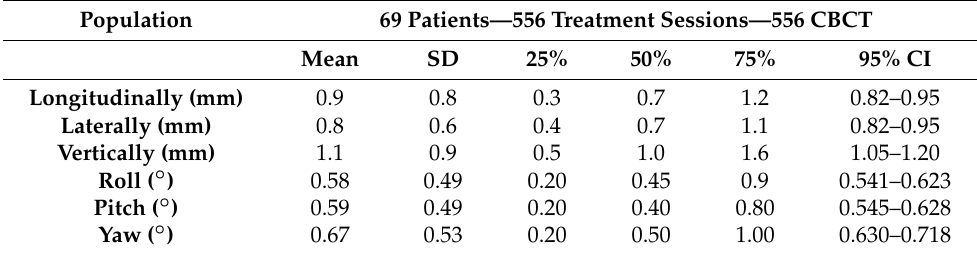
Table 2. Inter-fraction main summary statistical indices.